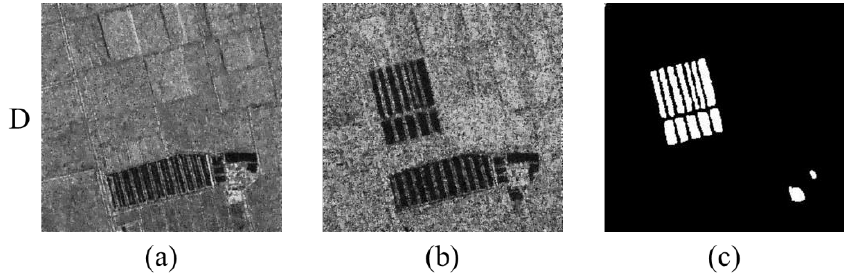
Figure 8. Yellow River A Dataset. ( a ) Image acquired in June 2008. ( b ) Image acquired in June 2009. ( c ) Ground-truth map.